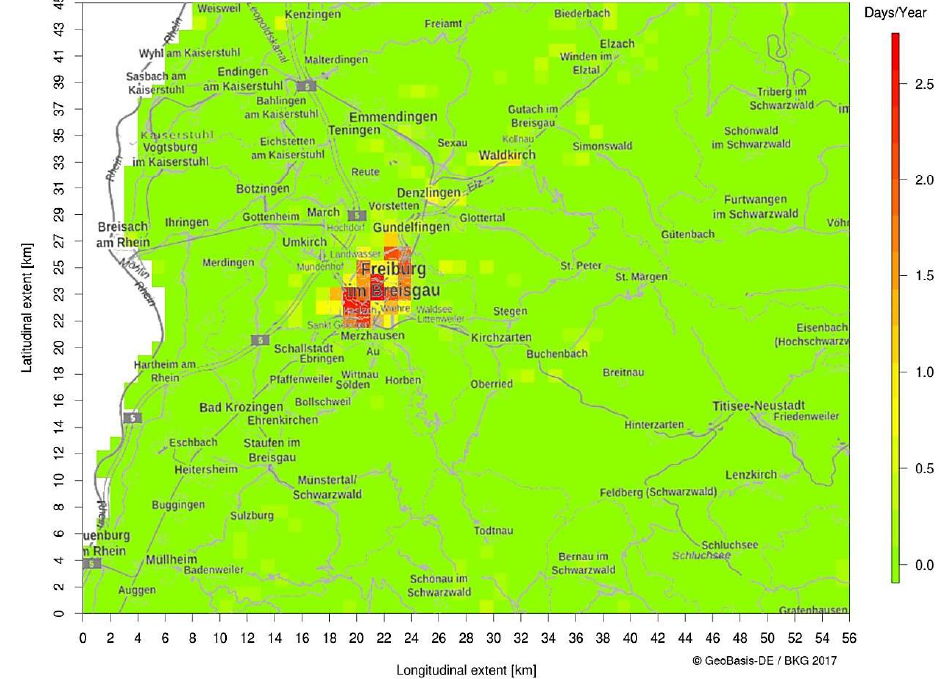
Figure 5. Spatial distribution of nightly heat stress expressed with the mean number of warm nights with T a, min 18—6 CET ≥ 14 °C within the study area of southern Baden over the time period 1995–2012. The calculation was conducted without consideration of acclimatisation effects.